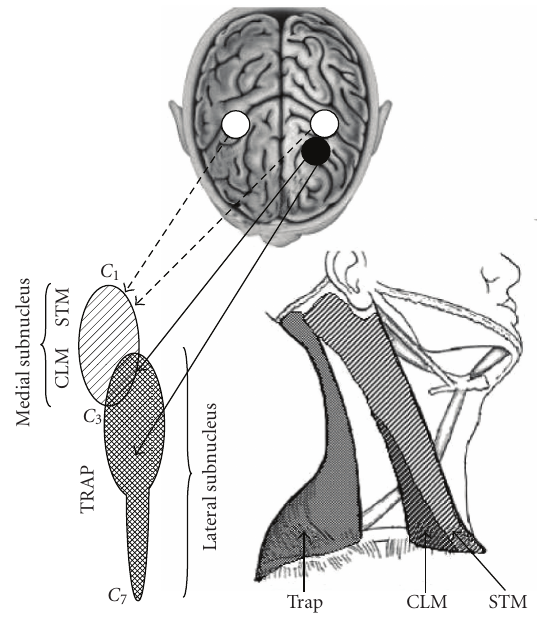
Figure 9: The accessory nucleus is composed of a medial and lateral subnucleus. The sternomastoid receives innervation from the medial subnucleus, which in turn receives bilateral projections from the primary motor cortex. The sternomastoid is thought to be exquisitely involved in oculomotor tracking. The cleidomastoid receives innervation from the caudal part of the medial subnucleus as well as the rostral lateral subnucleus. The trapezius receives innervation from the majority of the lateral subnucleus. The clei- domastoid and trapezius have contralateral cortical representations in the supplementary motor cortex and are believed to play a role in stabilization of the neck as well as locomotion in some